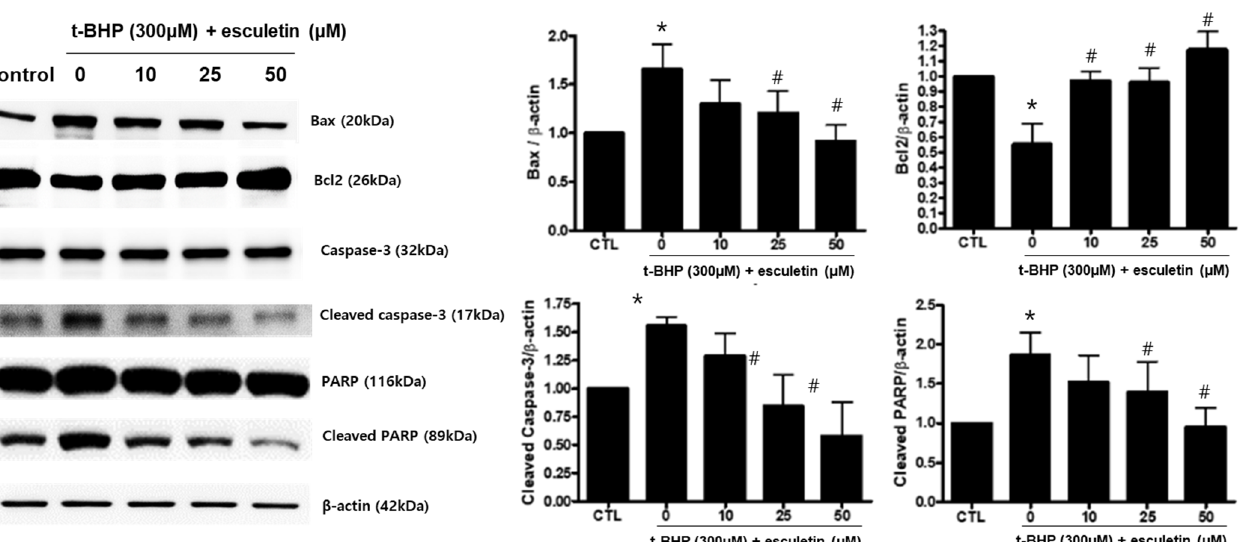
Figure 5. Effect of esculetin on the expression of apoptosis-related mRNA in HEK293 cells. The mRNA expression levels of Bax, bcl-2, caspase-3 and PARP. In the bar graphs, the values represent means ± SD, n = 5. * p < 0.05 vs. untreated control group, # p < 0.05 vs. t-BHP-treated group.